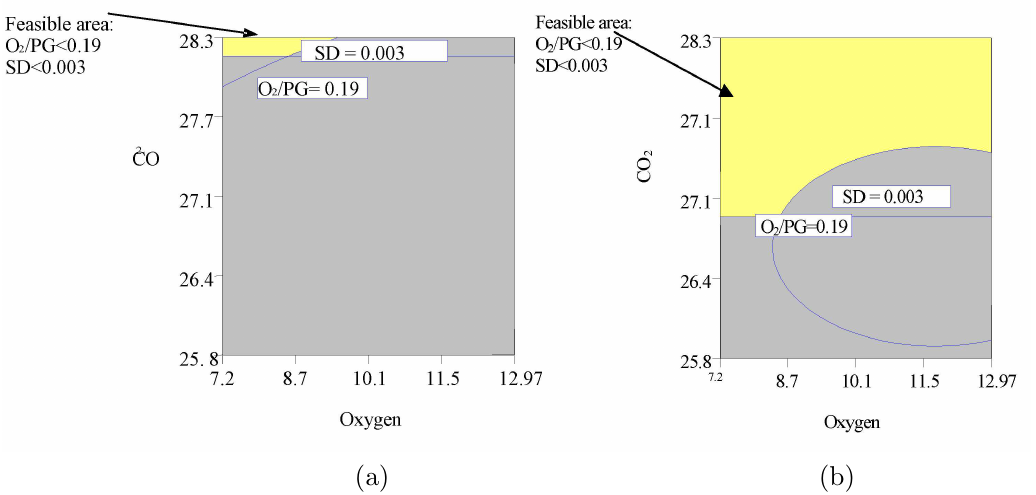
Figure 4: Operability regions for ˆ E ( y ( x, w, z = 10)) ≤ 0.19 m 3 n/m 3 n and ˆ σ simultaneously: (a) Typical broad PSD, (b) Finer